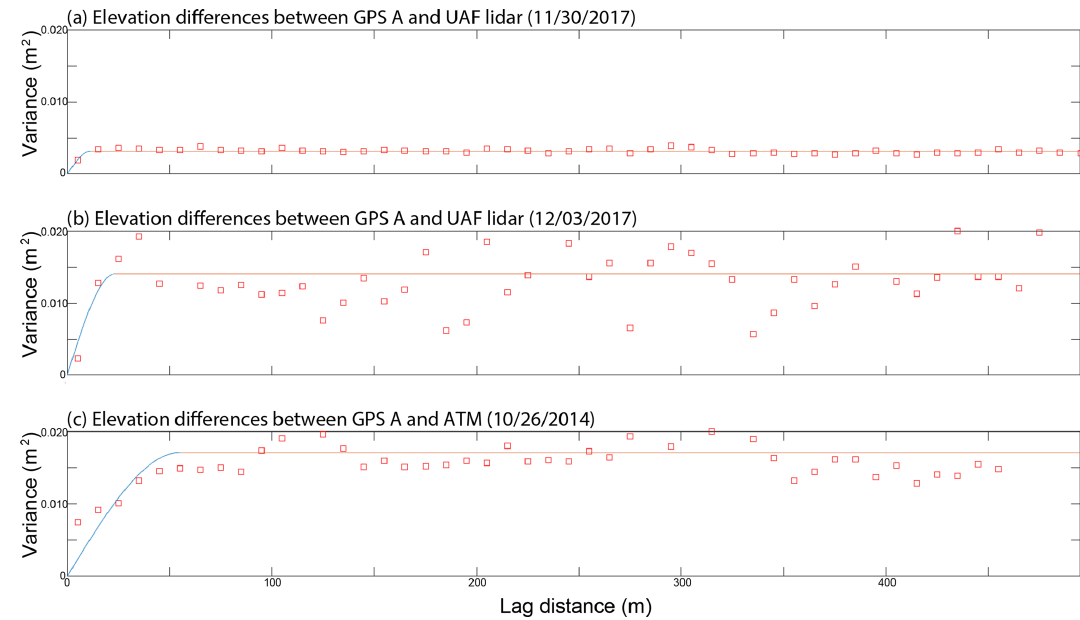
Figure 6. Semivariograms of elevation differences between GPS unit A and elevations derived from ATM (a) and the UAF lidar on 30 Novem- ber 2017 (b) and 3 December 2017 (c) . The x axes are lag distances between the observations, in meters, and the y axes are variance, in square meters. The red squares are the observed elevation differences in 50m bins and the lines represent a semivariogram model fit to these data.